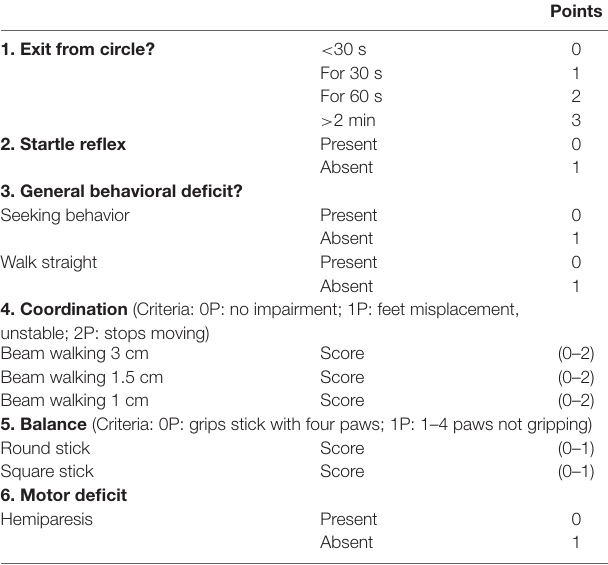
TABLE 1 | Modified Neurological Severity Score